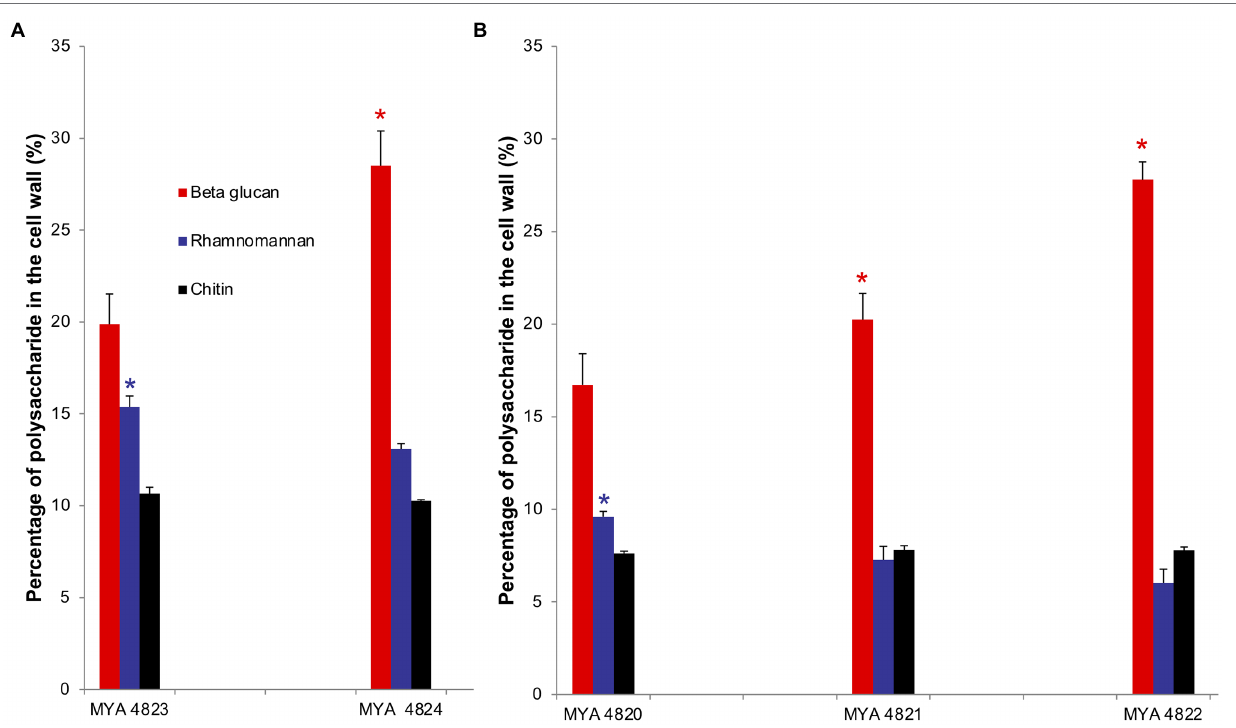
FIGURE 5 | Comparison of polysaccharides represented as percentage in the cell wall of S. brasiliensis (A) and S. schenckii (B) strains, yeast phase. Percentage of polysaccharides are represented in colored bars: β glucan (red), rhamnomannan (blue) and chitin (black). *Tukey Honestly Significant Difference (HSD) post hoc test was used for intra and inter species comparative analyses. Value of p < 0.05. Quantification of cell wall components was made by